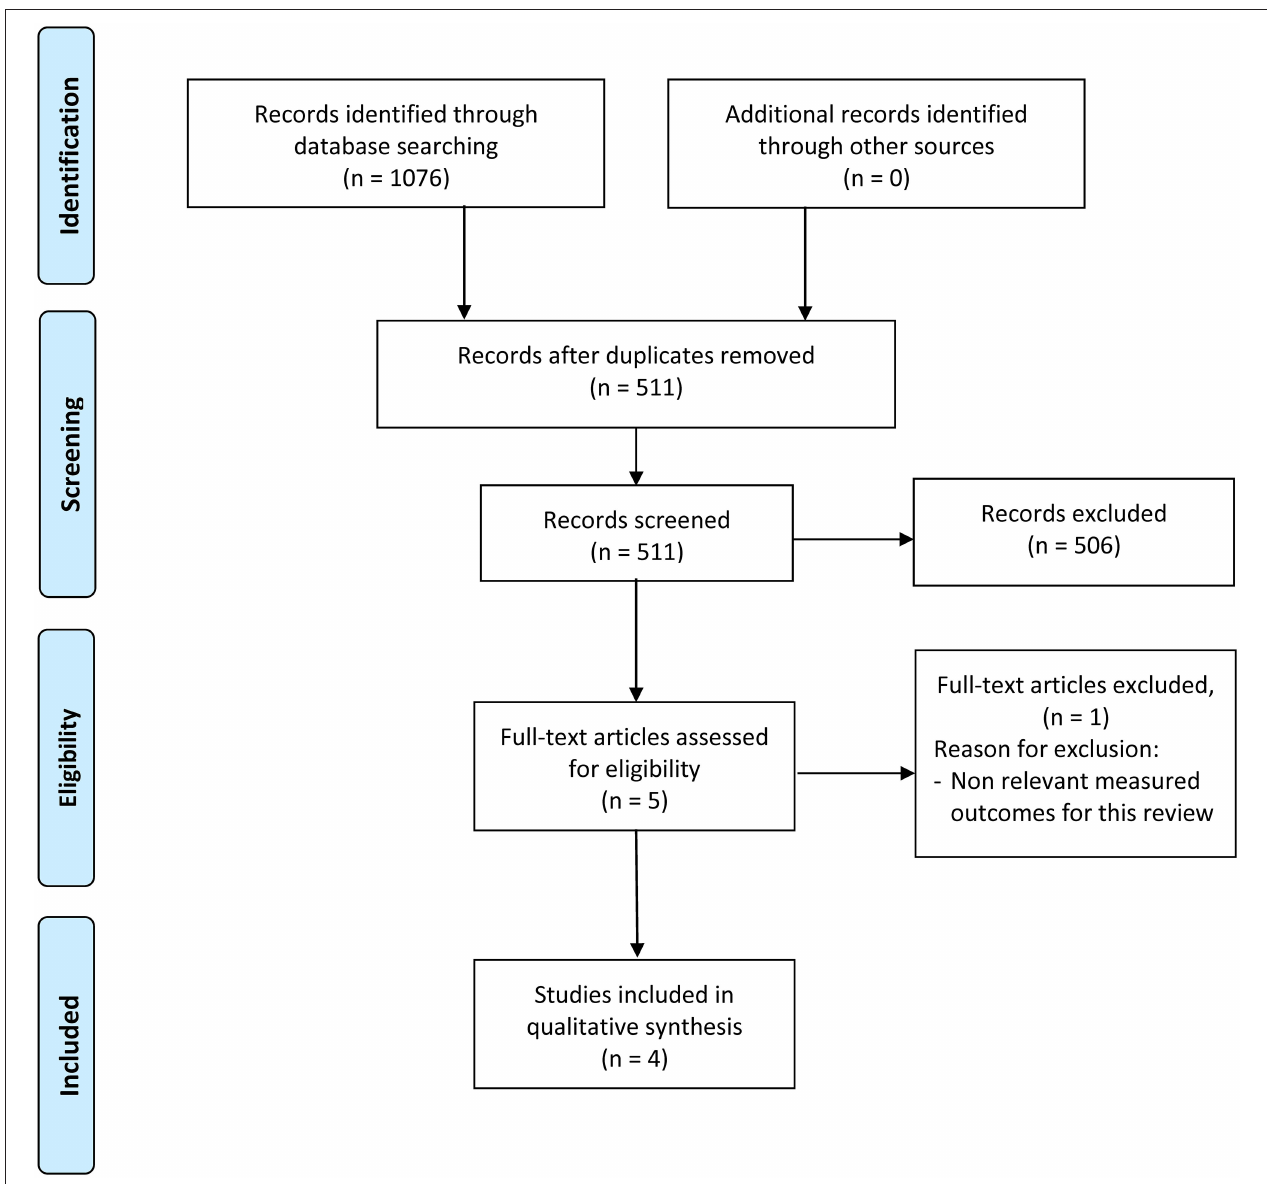
FIGURE 1 | PRISMA flow diagram outlining search